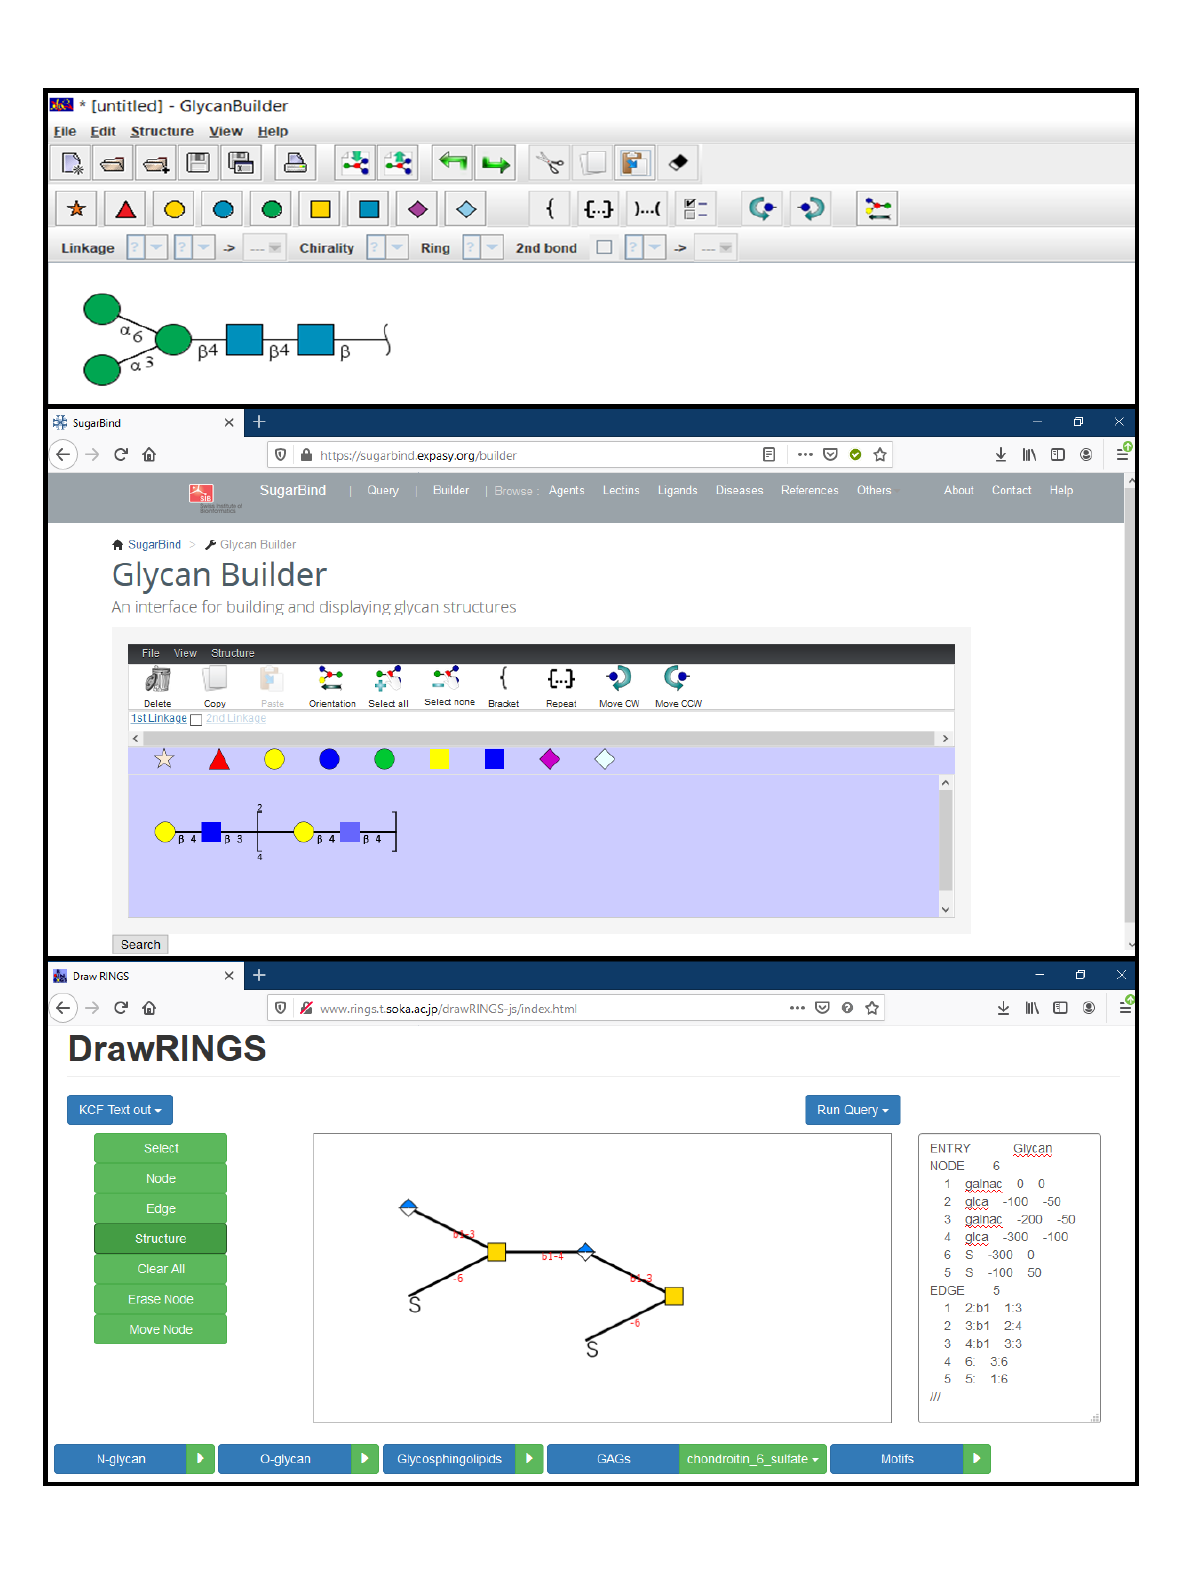
Figure 6: From top to bottom: GlycanBuilder2 [46] interface with a glycan image in SNFG notation. Original GlycanBuilder [47] interface with some of the available templates rendered as images. DrawRINGS [48] interface featuring a glycan and its KCF text